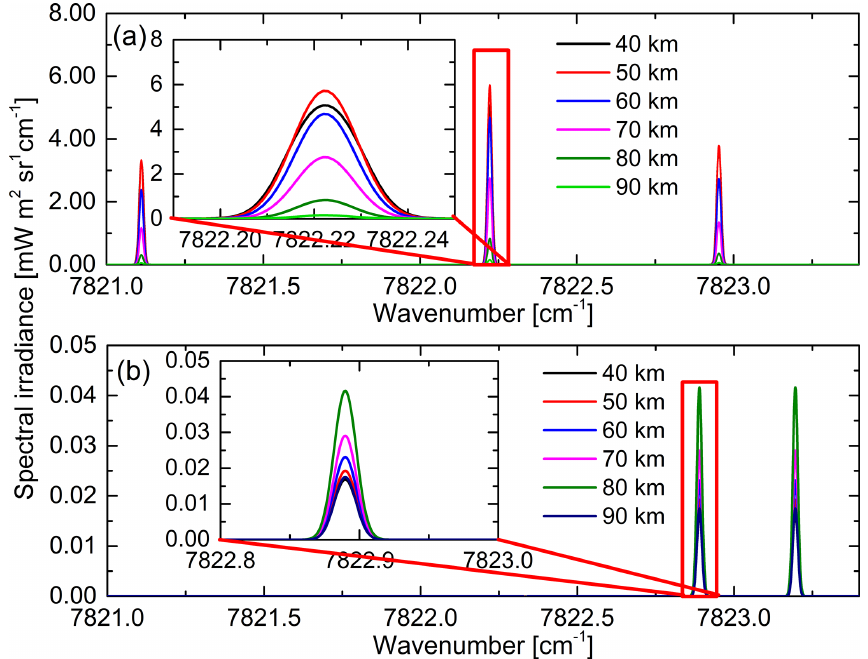
Figure 2. The spectral irradiance of the three emission lines of O 2 dayglow and the two emission lines of OH dayglow at tangent heights of 40, 50, 60, 70, 80 and 90km. (a) Three emission lines of O 2 dayglow. (b) Two emission lines of OH dayglow. The inset panels of (a) and (b) show a magnified view of a certain emission line of O 2 and OH dayglow, from which the linewidth and intensity varying with tangent heights can be seen more